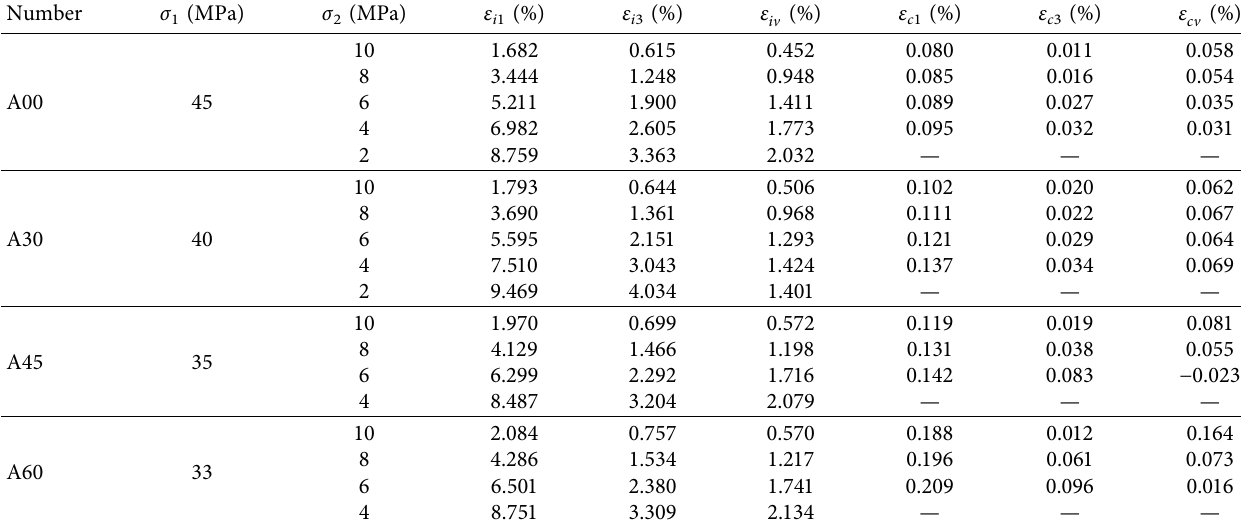
Table 2: Triaxial unloading creep test data of prefabricated cracked coal